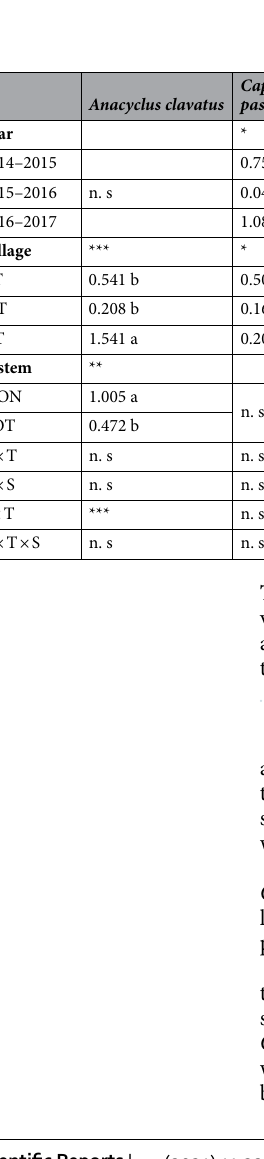
Lamium amplexicaule Lolium